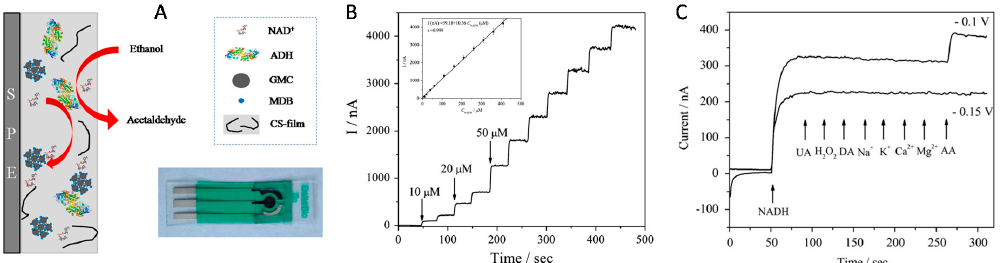
Figure 11. ( A ) Schematic illustration of an alcohol dehydrogenase (ADH)-based biosensor constructed from ADH/NAD + /Meldola’s blue (MDB)/graphitized mesoporous carbon (GMC)/chitosan (CS-film) nanobiocomposite on a screen-printed electrode (SPE, shown on the photograph). ( B ) Typical amperometric response upon successive addition of NADH (10, 20 and 50 µ M) in a stirred Tris-HCl buffer solution (0.1 M, pH 8.0, 300 rpm) at a working potential of − 0.15 V, and the corresponding calibration curve (inset). ( C ) Amperometric responses upon successive addition of 15 µ M NADH,